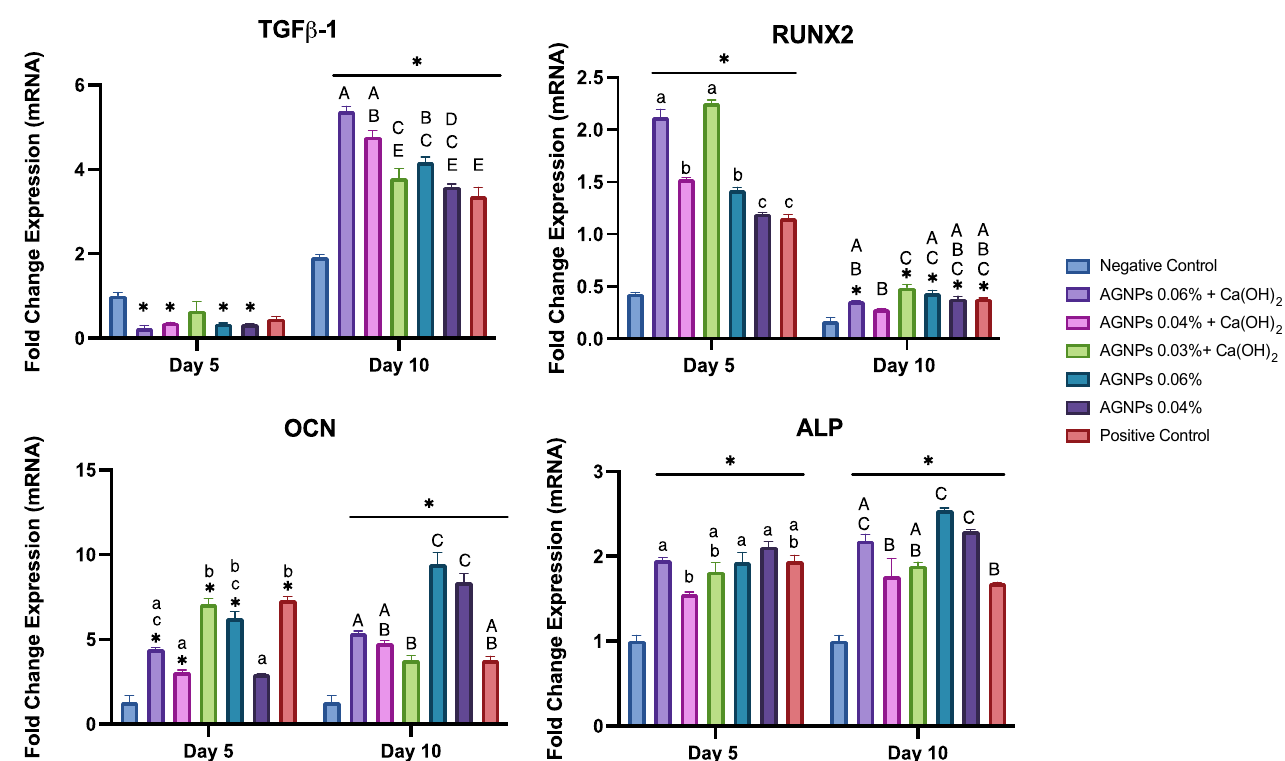
Figure 9. Results of qRT-PCR on days 5 and 10 after osteoblastic induction. Gene expression levels of TGF- β 1, ALP, and OCN were analyzed and normalized to GAPDH. Data are presented as mean ± SEM from three separate experiments. Different letters indicate a significant difference ( p < 0.05). Bars that have the same letter are not significantly different. Small letters are for day 5 and capital letters are for day 10 values. Asterisks (*) indicate statistical significance when compared with negative control (Negative control: cells in basal medium, Positive control: cells in osteogenic medium). [TGF- β 1: Transforming growth factor beta, Runx2: Runt-related transcription factor, ALP: Alkaline Phosphatase, OCN: Osteocalcin, Ca(OH) 2 : Calcium hydroxide, AgNPs: Silver nanoparticles] .